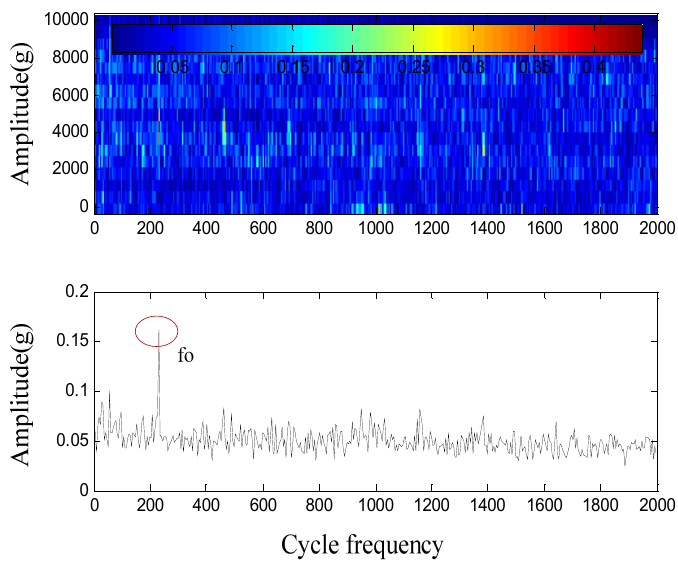
Figure 9. Processing results by FSC.